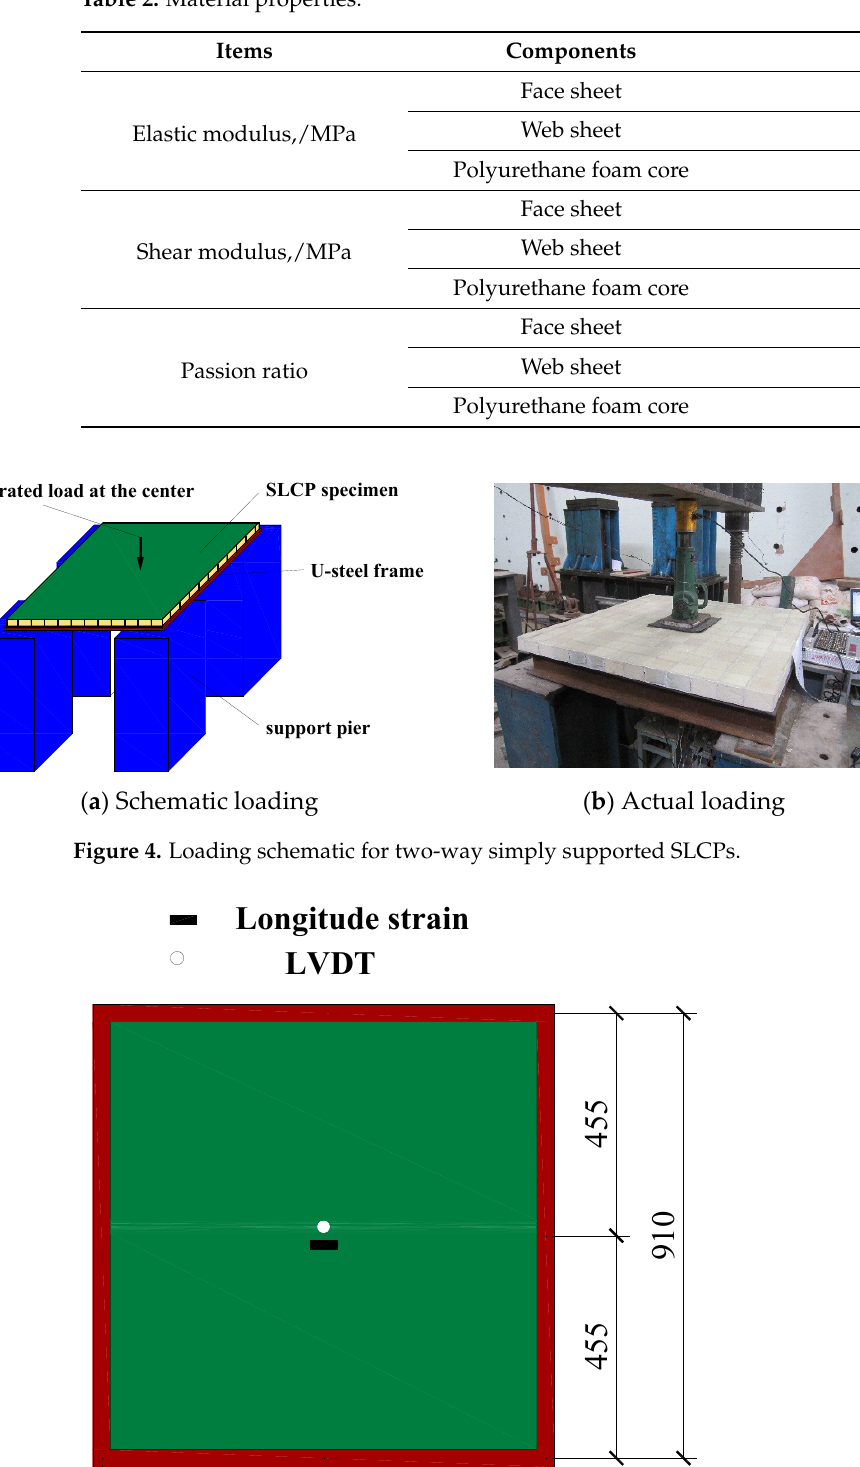
Table 2. Material properties.